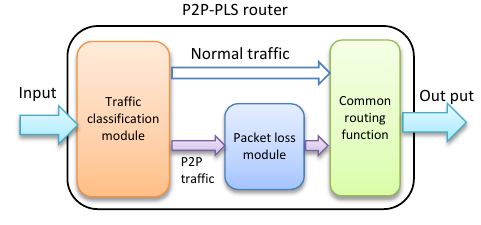
Fig. 2. PLS router